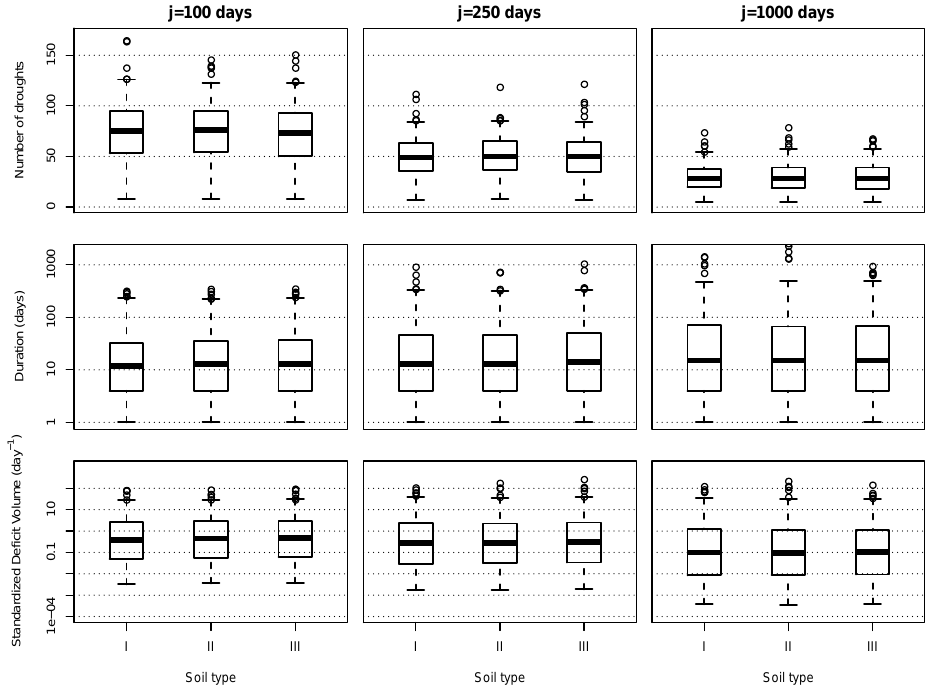
Fig. 5. Summary statistics (box: 25, 50 and 75 deciles, whiskers: 5 and 95 deciles) of hydrological drought characteristics (number of droughts, drought duration, standardized deficit volume) of all drought events (1495 grid cells) for three soils and three different groundwater systems. The circles represent extreme events beyond D95 for the 96, 97, 98, 99 and 100 deciles. Please note that y-axis is on log scale.